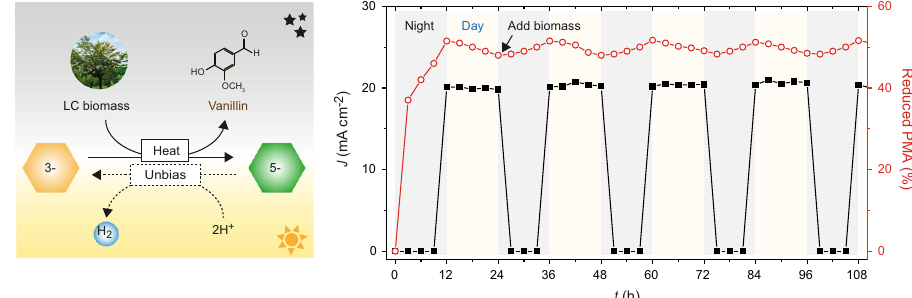
Fig. 4 | Continuousand repeatedoperationofbiomassPECsystems. PMAwasreduced upon concurrent depolymerization and valorization of LCbiomassatnight (at 60°C for 12h), then used to produce hydrogen ef fi ciently during the daytime (under simulated solar irradiation for